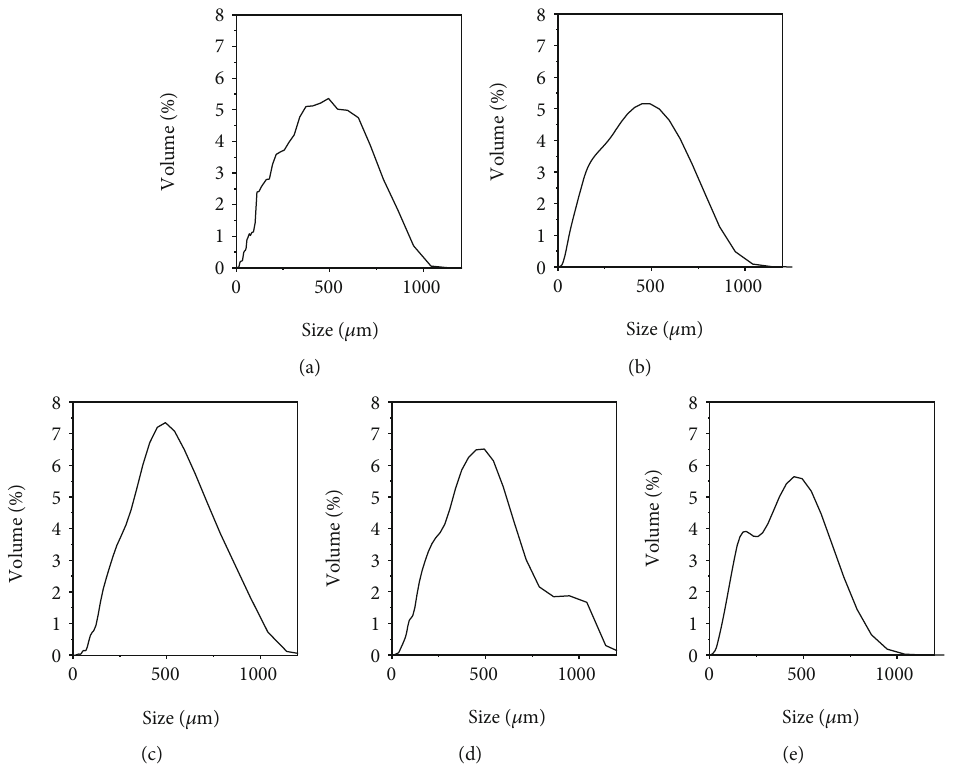
Figure 7: The particle size distribution of PPAs: (a) PPU, (b) PPSA, (c) PPSI, (d) PPST, and (e) PPSY.